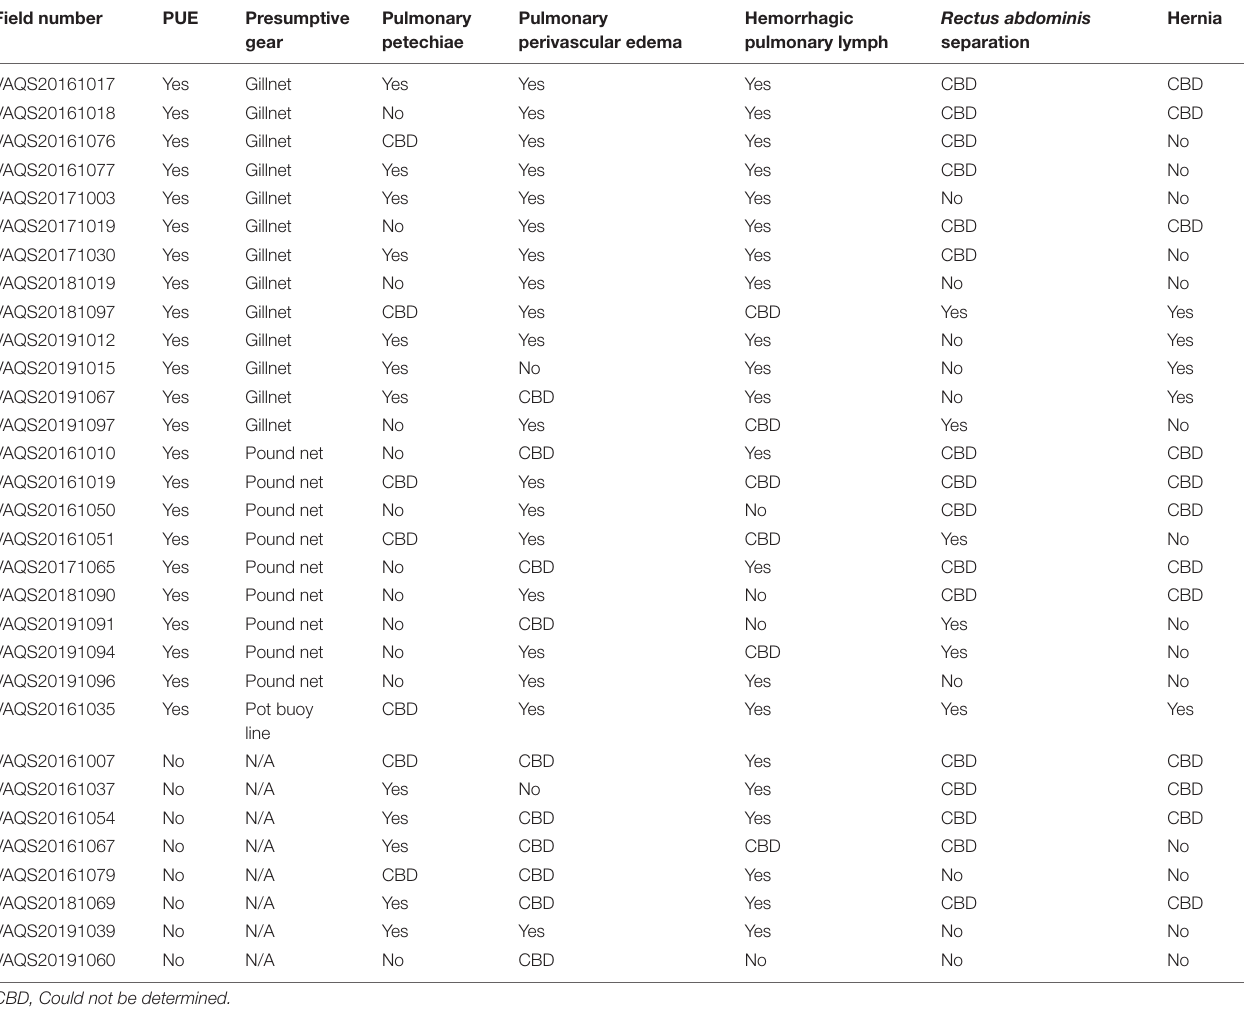
TABLE 1 | Internal lesion presence for each case.